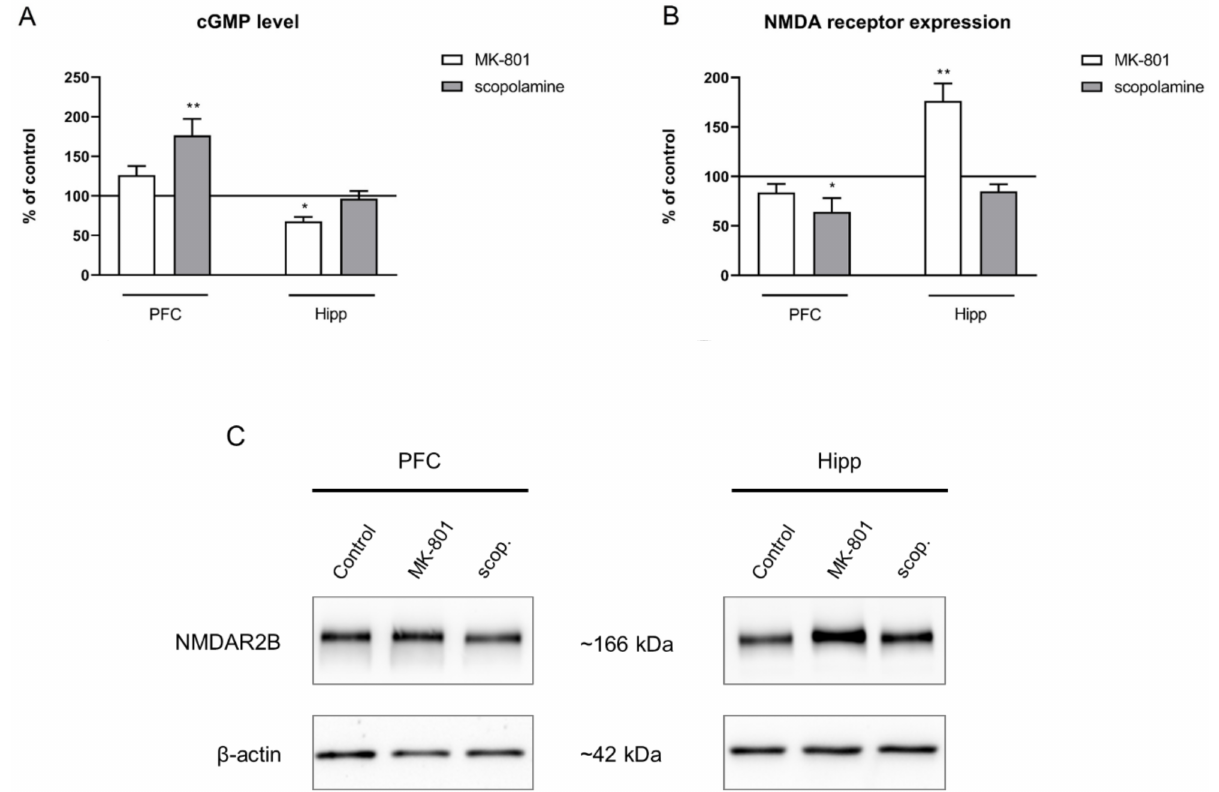
Figure 7. cGMP level ( A ) and GluN2B subunit-containing NMDA receptor expression ( B ) in the prefrontal cortex (PFC) and hippocampus (Hipp) after acute administration of MK-801 (0.3 mg/kg) or scopolamine (1 mg/kg). Representative Western blots ( C ). Data are presented as means ± SEM. * p < 0.05; ** p < 0.01 vs.